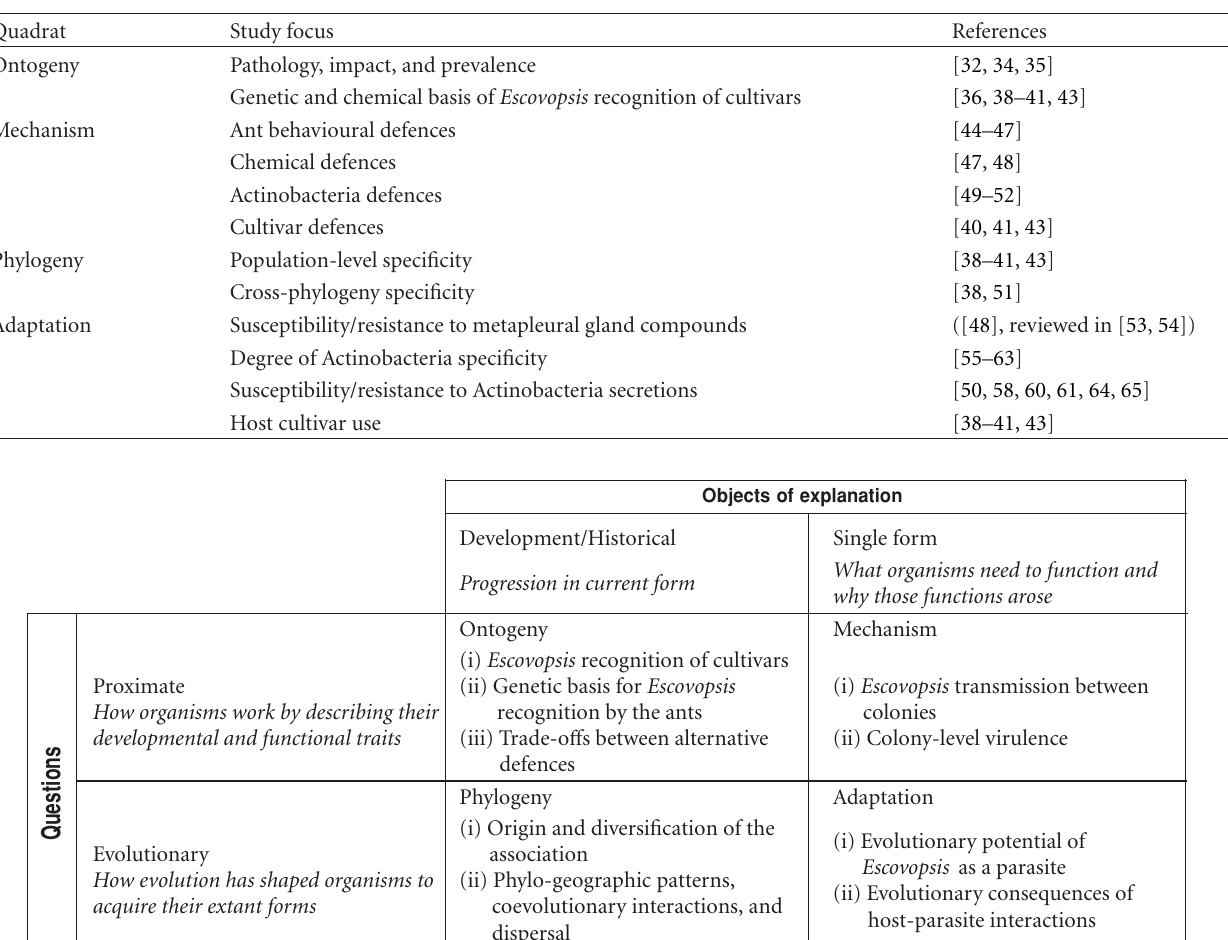
Table 1: Overview of available studies on Escovopsis virulence in gardens of fungus-growing ants, and our assortment of these studies into the four Tinbergen quadrats.